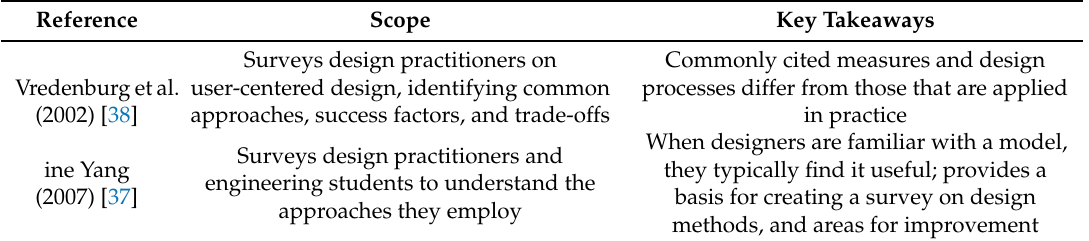
Table 4. Design practitioner